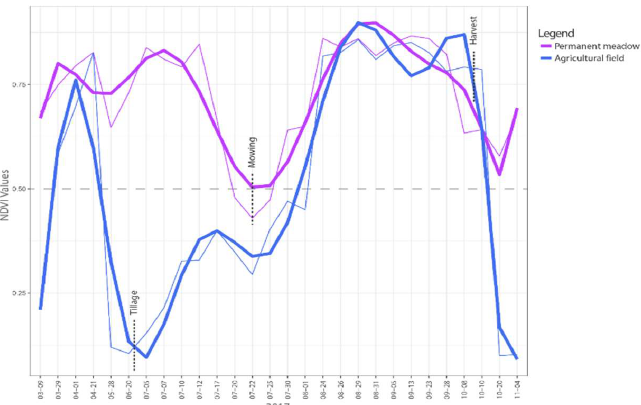
Figure 2. Growth cycle of a permanent meadow and crop field with no irregularities in the 2017 growing season, shown on the layer of NDVI vegetation index derived from Sentinel-2 imagery acquired at different times. Dark green shades represent high NDVI values and active vegetation.